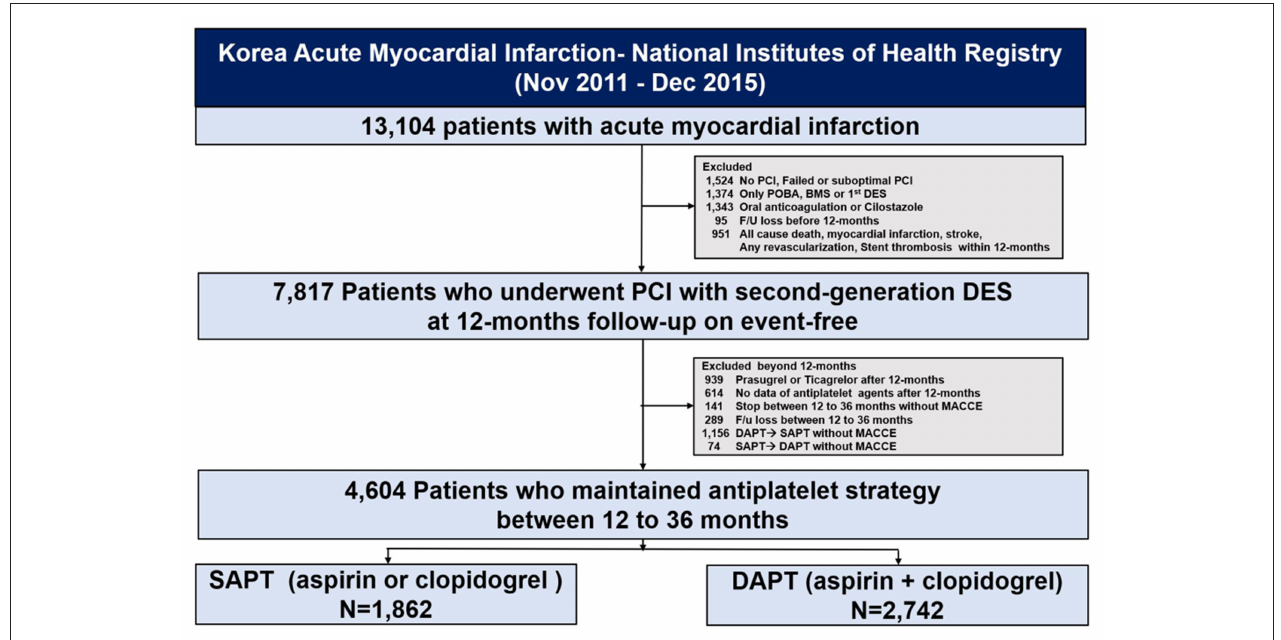
FIGURE 1 | Study flowchart. PCI, percutaneous coronary intervention; POBA, plain old balloon angioplasty; BMS, bare-metal stent; DES, drug-eluting stents; PLT, platelet; MACCE, major adverse cardiac and cerebrovascular events; SAPT, single antiplatelet therapy; DAPT, dual antiplatelet